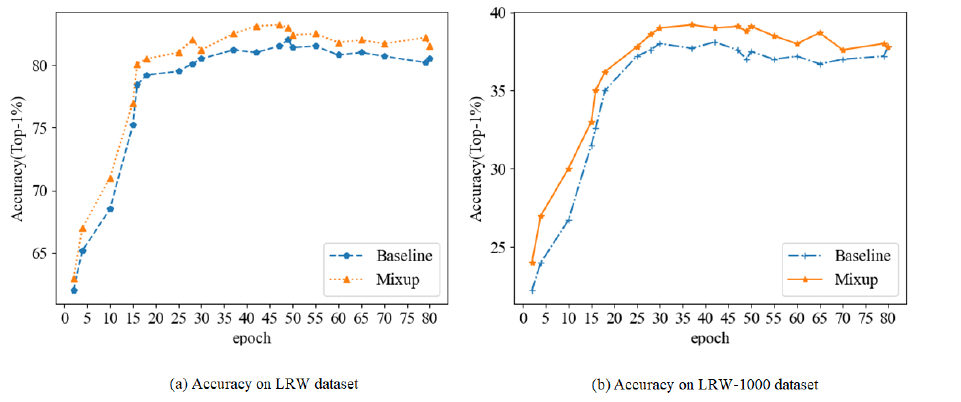
Figure 7. TestSet accuracy of Mixup and baseline model. ( a ) TestSet accuracy on LRW dataset. ( b ) TestSet accuracy on LRW-1000